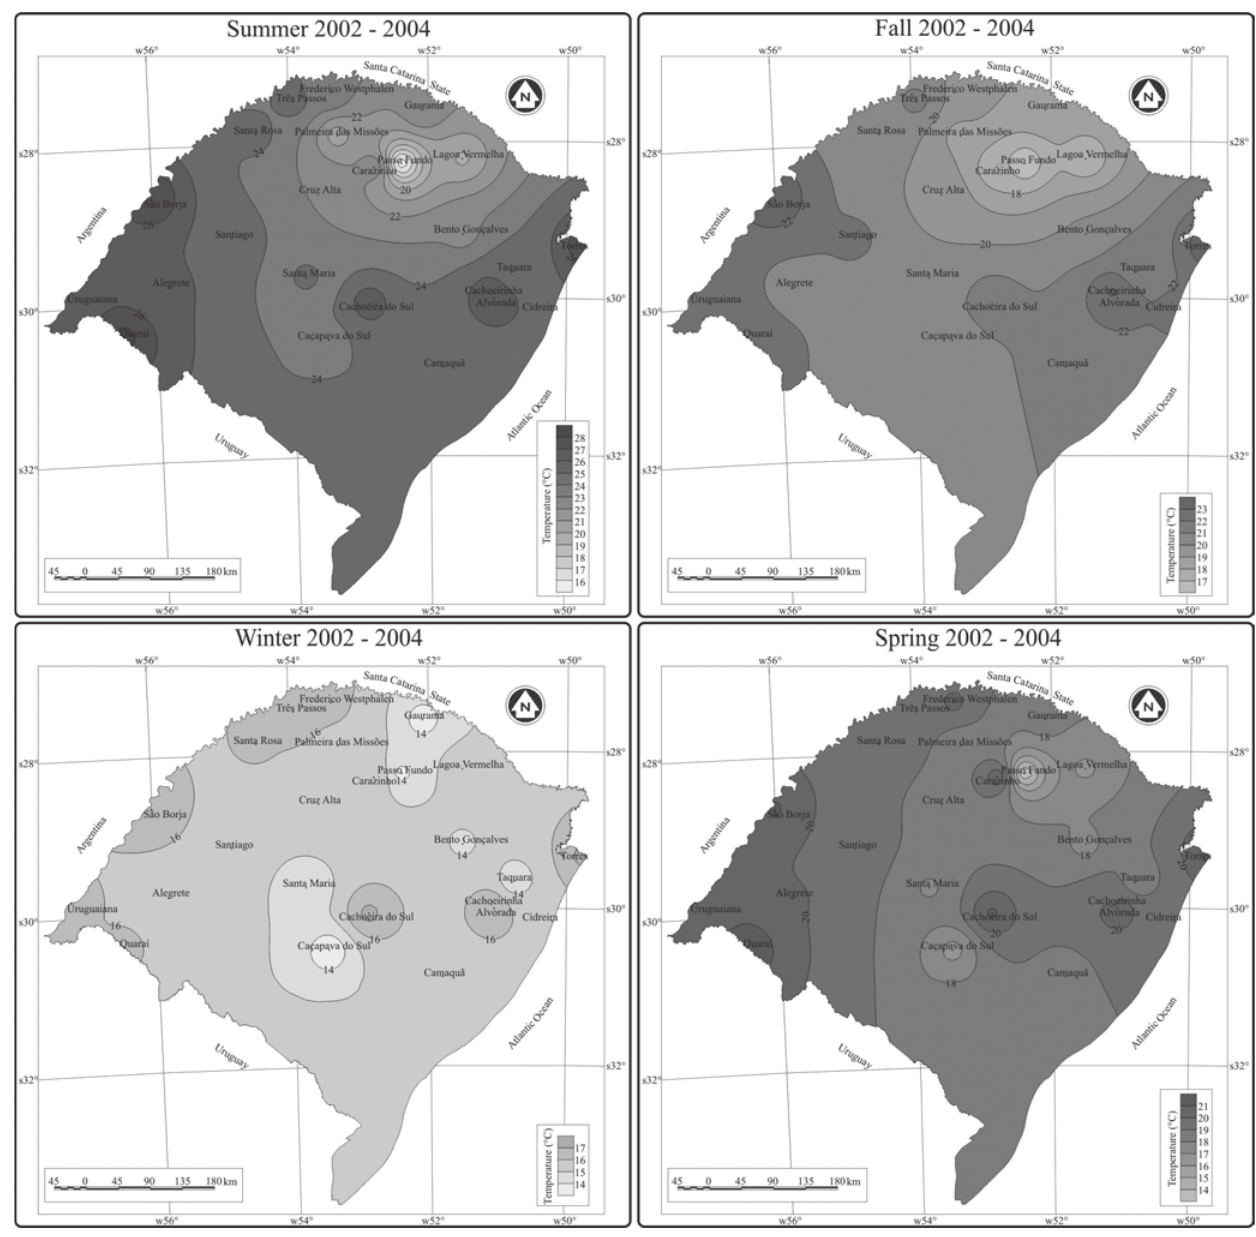
Fig. 3. Mean water temperature in several cities of the state of Rio Grande do Sul from 2002 to 2004 (Source